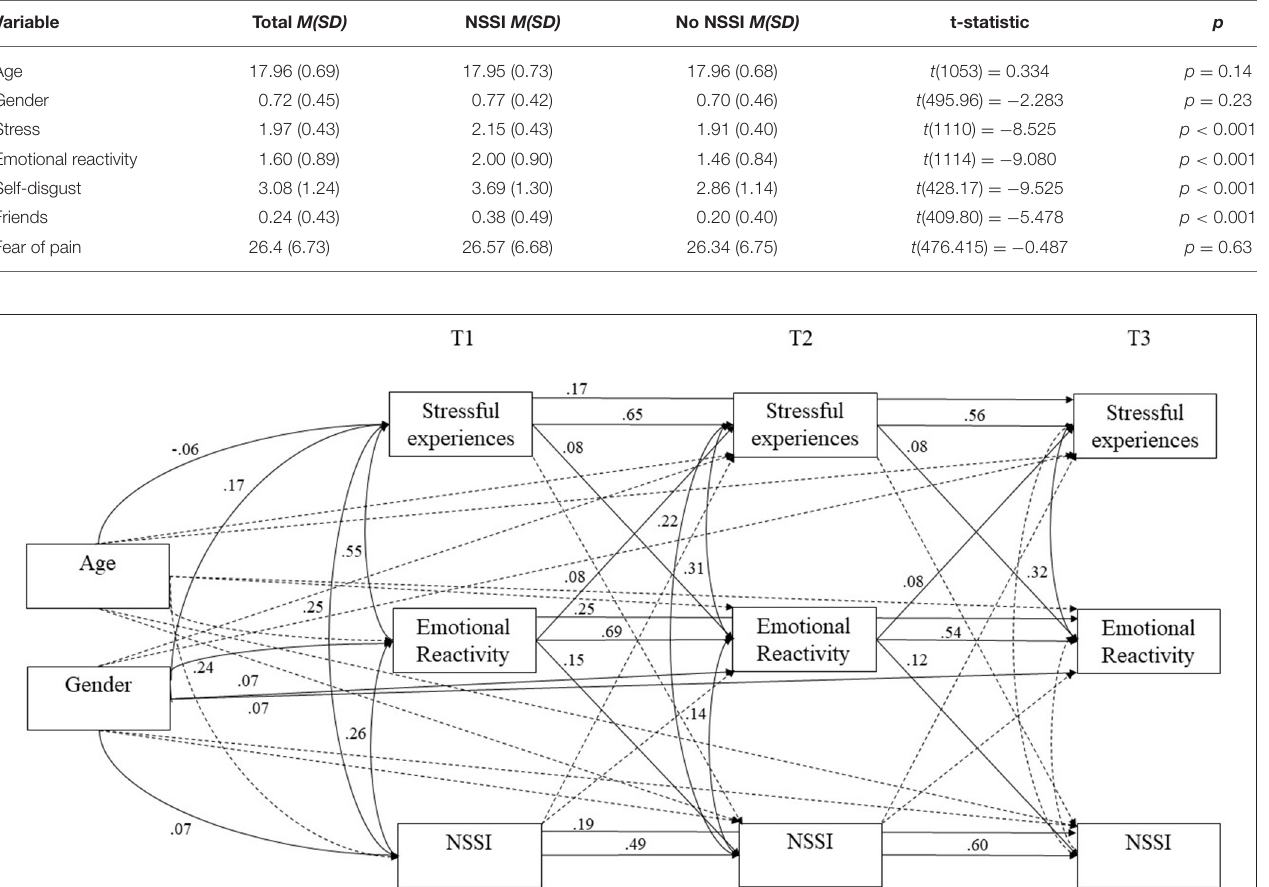
stronger for those who reported having friends who engaged in NSSI, high levels of self-disgust, and low fear of pain (relative to those without these NSSI specific risk factors). This hypothesis was not supported; the indirect effect of stressful experiences on NSSI was maintained across individuals with and without the NSSI specific risk